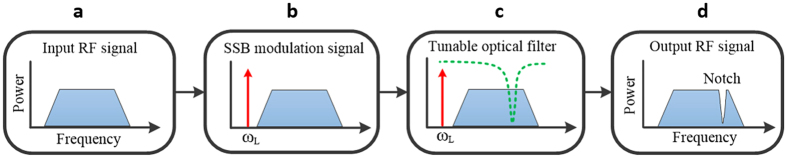
Operating principle of the tunable MWP notch filter.